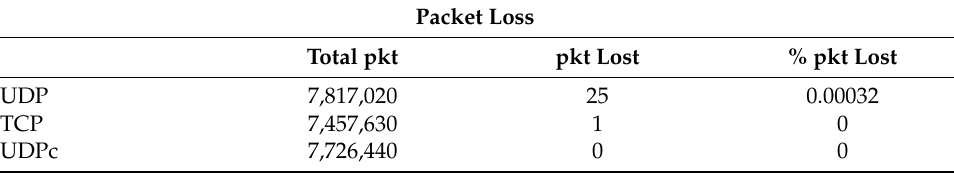
Table 3. Lost FSoE Packet Statistics for different transport layers on IEEE802.11.